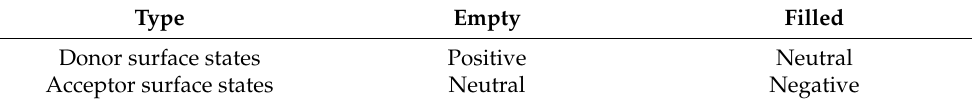
Table 1. Electrical properties of donor and acceptor surface states.